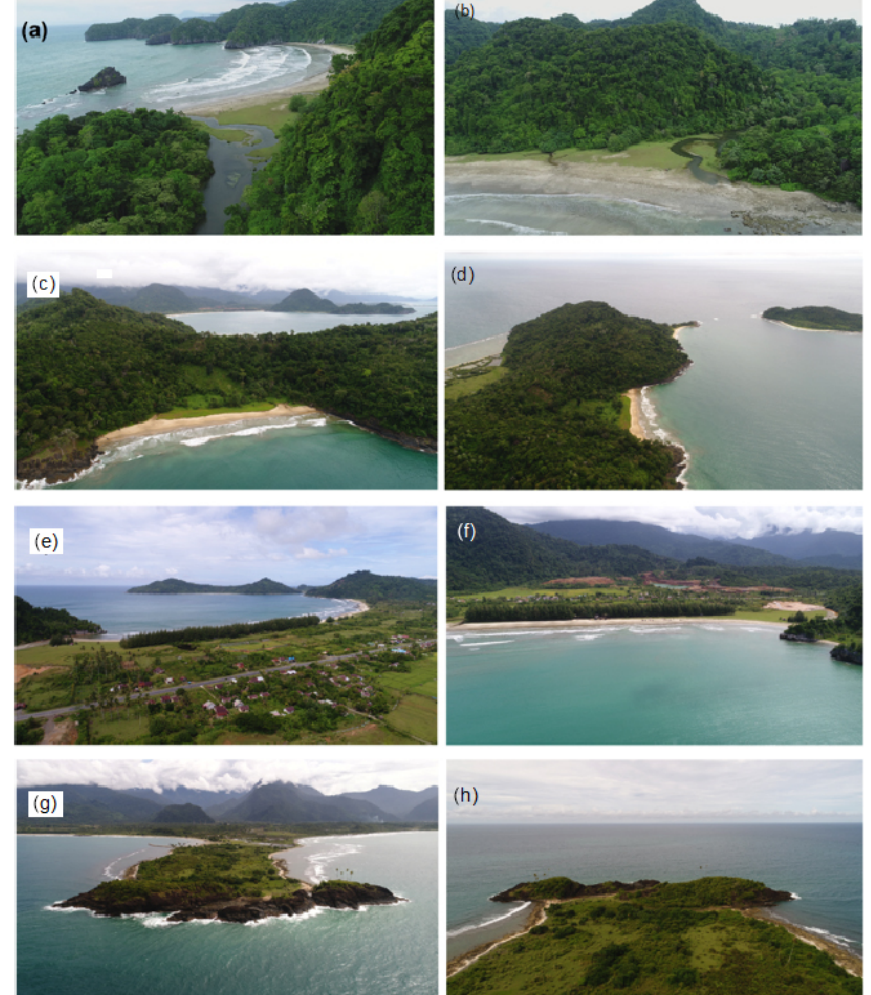
Figure 2. Aerial drone photos of the study areas at Birek (a, b) , Pasie Janeng (c, d) , Jantang (e, f) , and Saney (g, h) captured in October